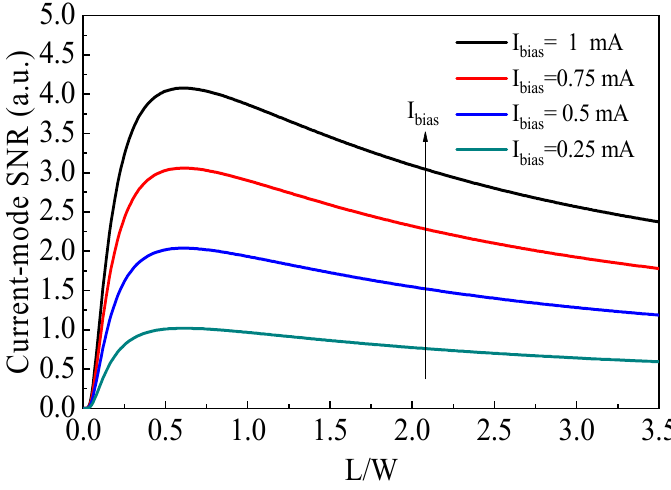
Figure 5. SNR as a function with L / W ration when a cross-like Hall plate is operating in the current mode.